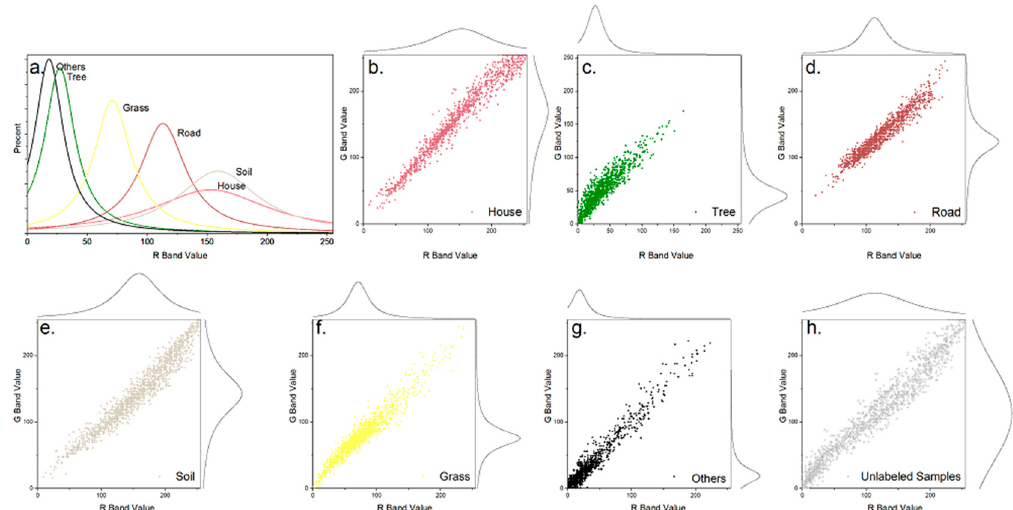
Figure 8. Spectral spaces, consisting of the R-band and G-band, for Area 6 with balanced samples. The x-axis represents the R band, and the y-axis represents the G band. Sub-figure shows the spectral overlap on the R-band in the same coordinate space for all classes. Sub-figure ( a ) shows the percent distribution of R band values for all six classes. Sub-figure ( b ~ g ) shows the feature distribution of each class in this R-G space (( b ): House; ( c ): Tree; ( d ): Road; ( e ): Soil; ( f ): Grass; ( g ): Others). Sub figure ( h ) shows the distribution of unlabeled samples in the R-G space.